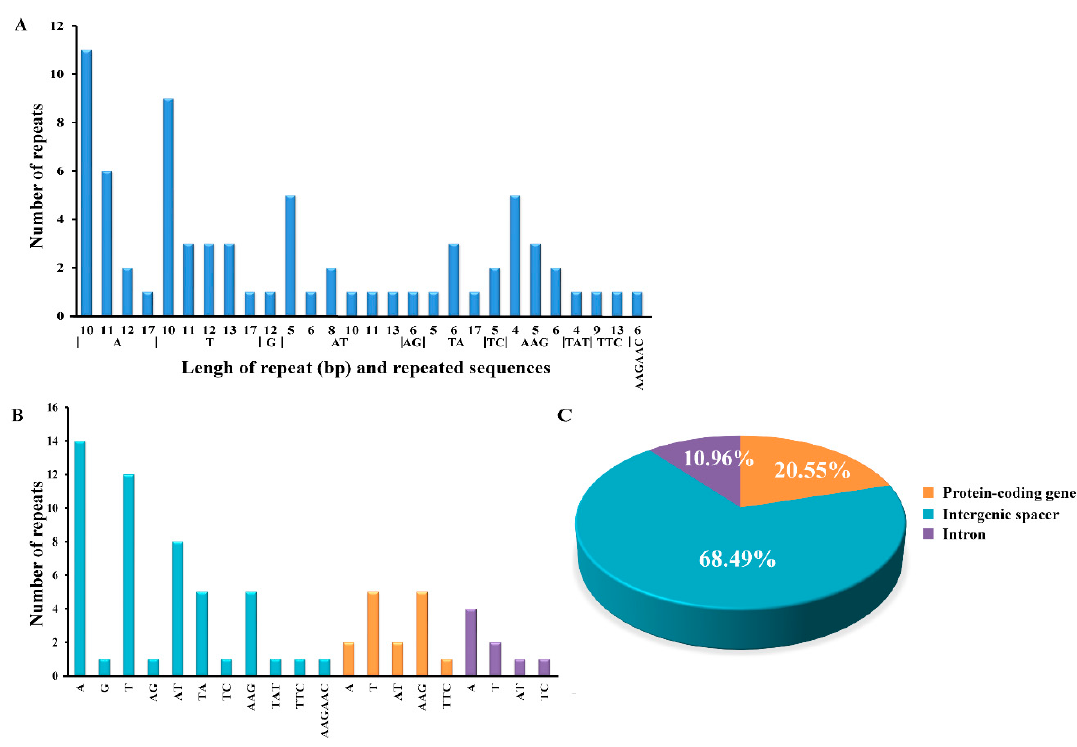
Figure 4. Simple sequence repeats in the cp genome of F. hodginsii . ( A ) Statistics of simple sequence repeats (SSRs) classified by sequence length. ( B ) Quantity statistics of SSRs according to their locations. ( C ) The proportion of regions containing SSRs.